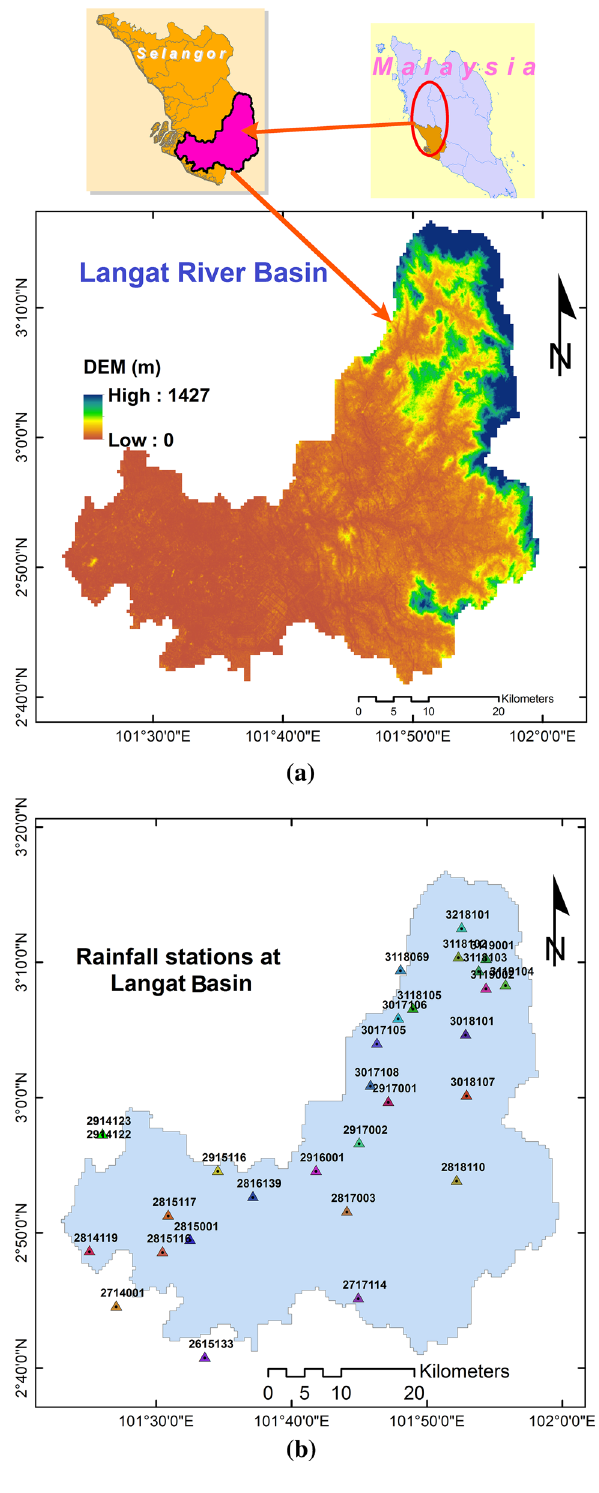
Fig. 1 Location of the study area ( a ) and spatial distribution of rain gauge stations ( b